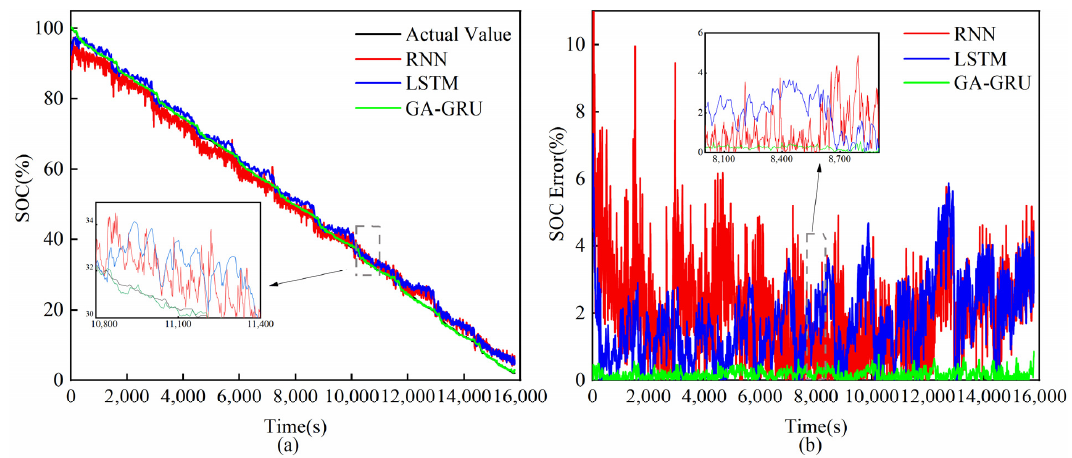
Figure 6. SOC estimation results and errors under DST at 0 °C. ( a ) Comparison of SOC estimation results under DST at 0 °C; ( b ) comparison of SOC estimation errors under DST at 0 °C.